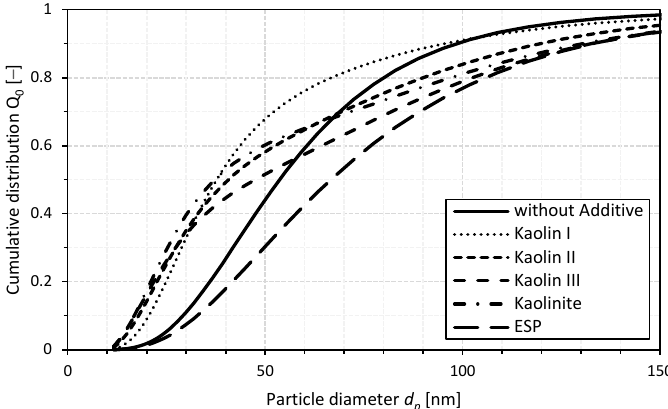
Figure 3. Particle size number distributions of the particulate matter (PM) emissions for the combustion of non-additivated (without and with electrostatic precipitator (ESP)) and additivated (0.5 wt% Kaolin I, Kaolin II, Kaolin III, and Kaolinite) wood chips.